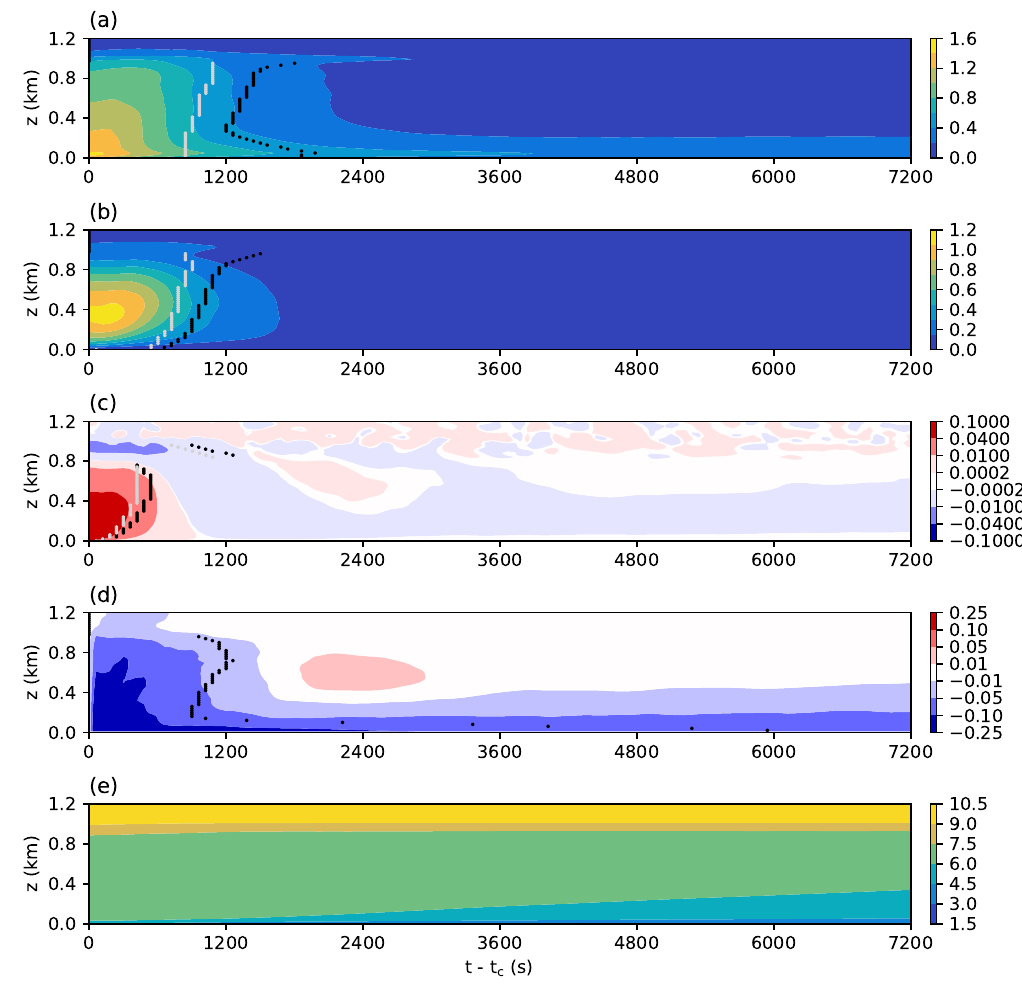
Figure 11. Time series of vertical profiles of ( a ) TKE, ( b ) vertical velocity variance, ( c ) vertical heat flux, ( d ) vertical momentum flux, and ( e ) time- and slab-averaged streamwise velocity in the advective CBL. The logarithmic horizontal axis indicates the time after t = t c . The black and gray dots indicate the e -folding decay times in the advective and free CBL simulations,